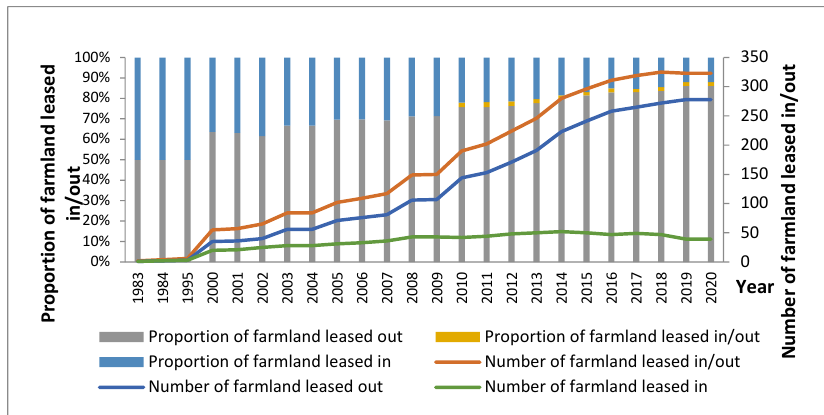
Figure 2. Households of farmland leasing in Huang village.